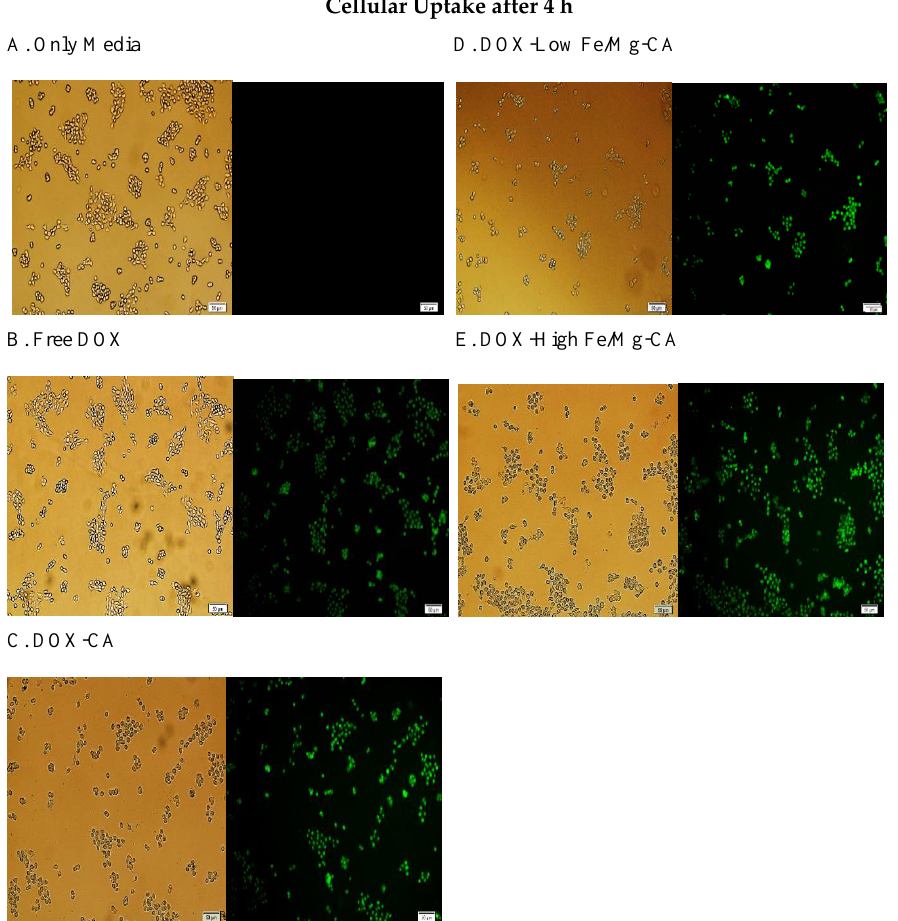
Figure 13. Representative images of cellular uptake in MCF-7 cells after 4 h of treatment. ( A ) Only media ( B ) Free DOX (5 µM DOX) ( C ) DOX-loaded CA (5 µM DOX, 4 mM Ca 2+ ) ( D ) DOX-loaded low Fe/Mg-CA (5 µM DOX, 4 mM Ca 2+ ,1 µM Fe 3+ , 4 mM Mg 2+ ) ( E ) DOX-loaded high Fe/Mg-CA (5 µM DOX, 4 mM Ca 2+ , 5 µM Fe 3+ , 12 mM Mg 2+ ).